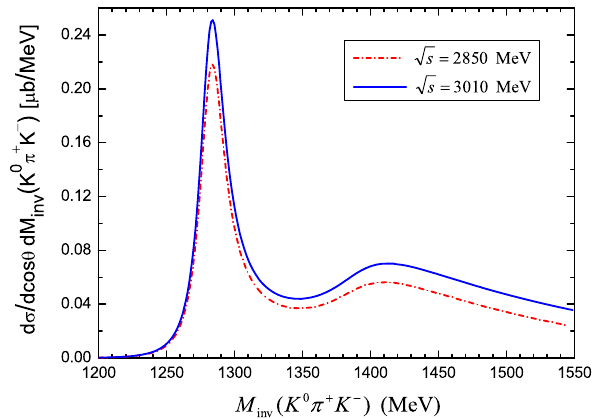
Fig. 5 d σ/ [ d t d M inv ( K 0 π + K − ) ] for at M inv = 1550